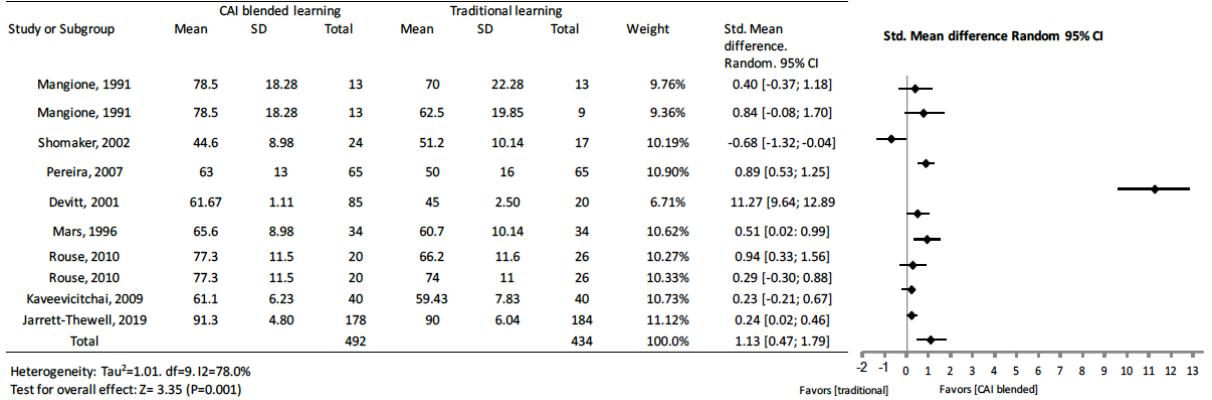
Figure 7. Forest plot of computer-assisted instruction blended learning to traditional learning comparison for knowledge outcomes. df: degree of freedom; CI: confidence interval.